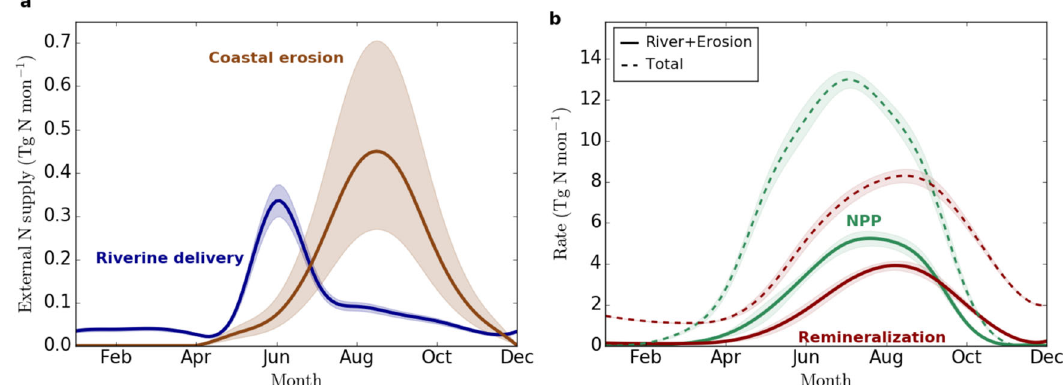
Fig. 2 Climatology of terrigenous nitrogen input, ocean net primary production and remineralisation in the Arctic Ocean over 2005 – 2010. Climatologies of a basin-wide terrigenous nitrogen input from rivers (blue) and coastal erosion (brown) and of b total basin-wide integrated net primary production (NPP) (green) and pelagic and benthic remineralisation of organic matter (red). Total NPP and remineralisation are indicated as dashed lines (Baseline simulation) while NPP and remineralisation only driven by terrigenous inputs are shown as solid lines (computed as the difference between the Baseline and NoTerr simulations). The envelopes represent a uncertainties for the terrigenous nitrogen input (see methods) as well as b the simulated interannual standard deviation of NPP and remineralisation over 2005 –